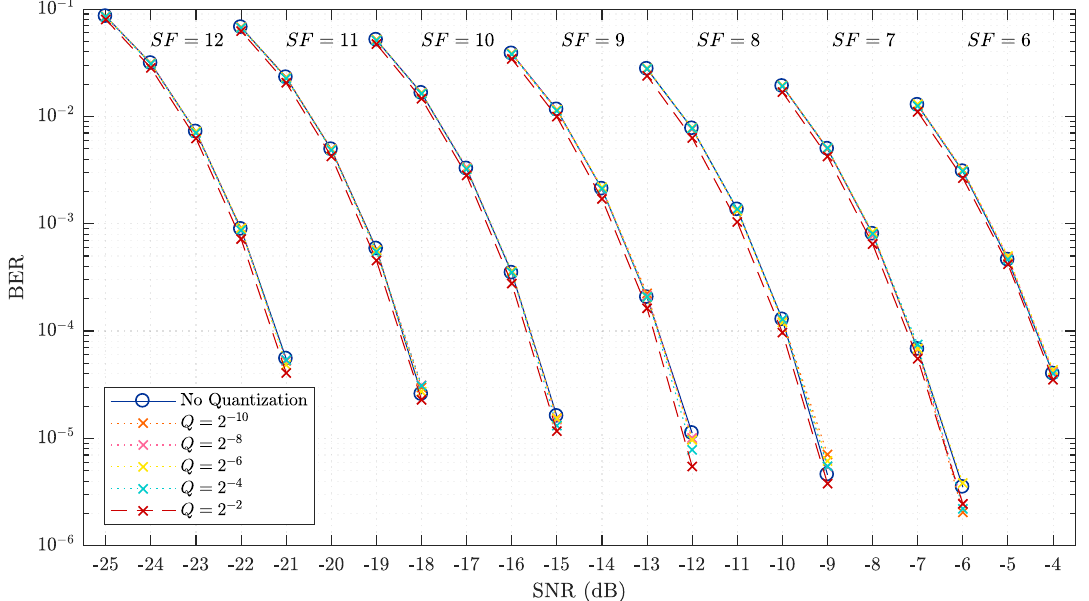
Figure 5. Bit-error-rate (BER) results for quantized and non-quantized signals with BW = 125 kHz and SF ranging from 6 to